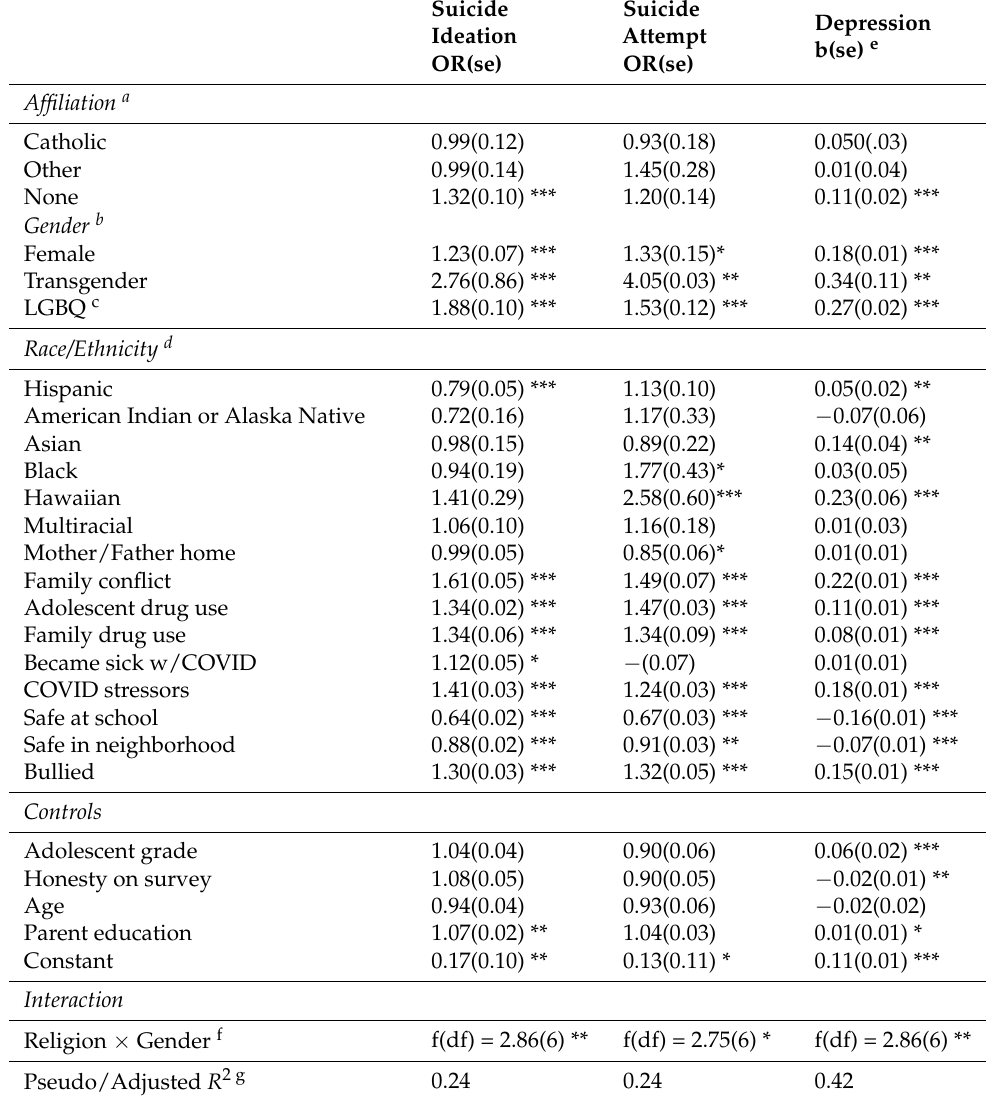
Table 4. Regression parameters for final models (n =